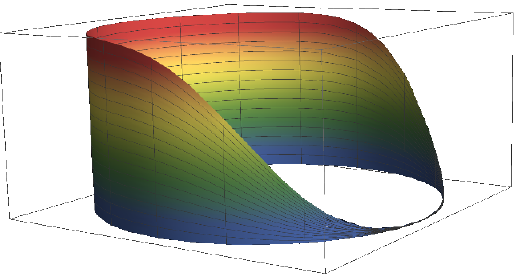
Figure 12 . Visualization of our low-pass Fourier (cid:12)lter for periodic functions. Modes with wavevec- tor j k j =N & 2 are suppressed. The (cid:12)lter width (cid:14) is chosen to be 1 = 3